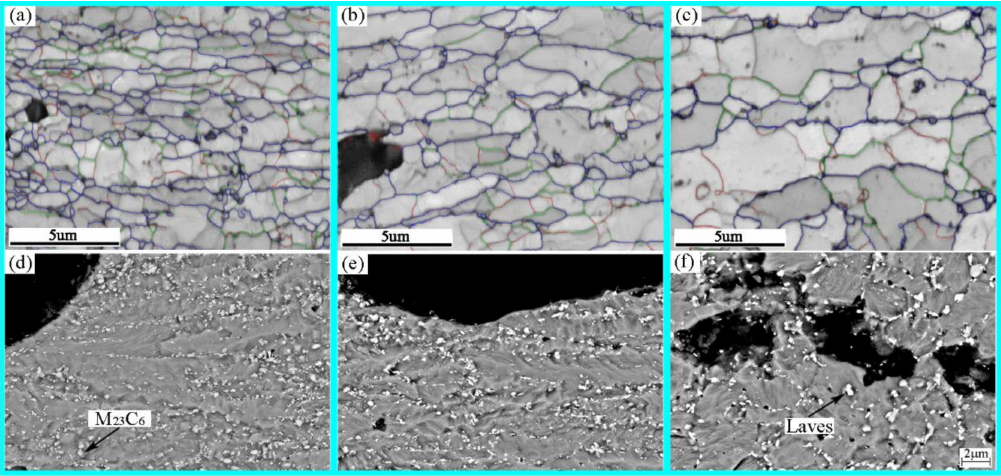
Figure 5. The microstructure near the fracture under different stress: ( a ) 140 MPa EBSD; ( b ) 120 MPa EBSD; ( c ) 100 MPa EBSD; ( d ) 140 MPa BSE; ( e ) 120 MPa BSE; ( f ) 100 MPa